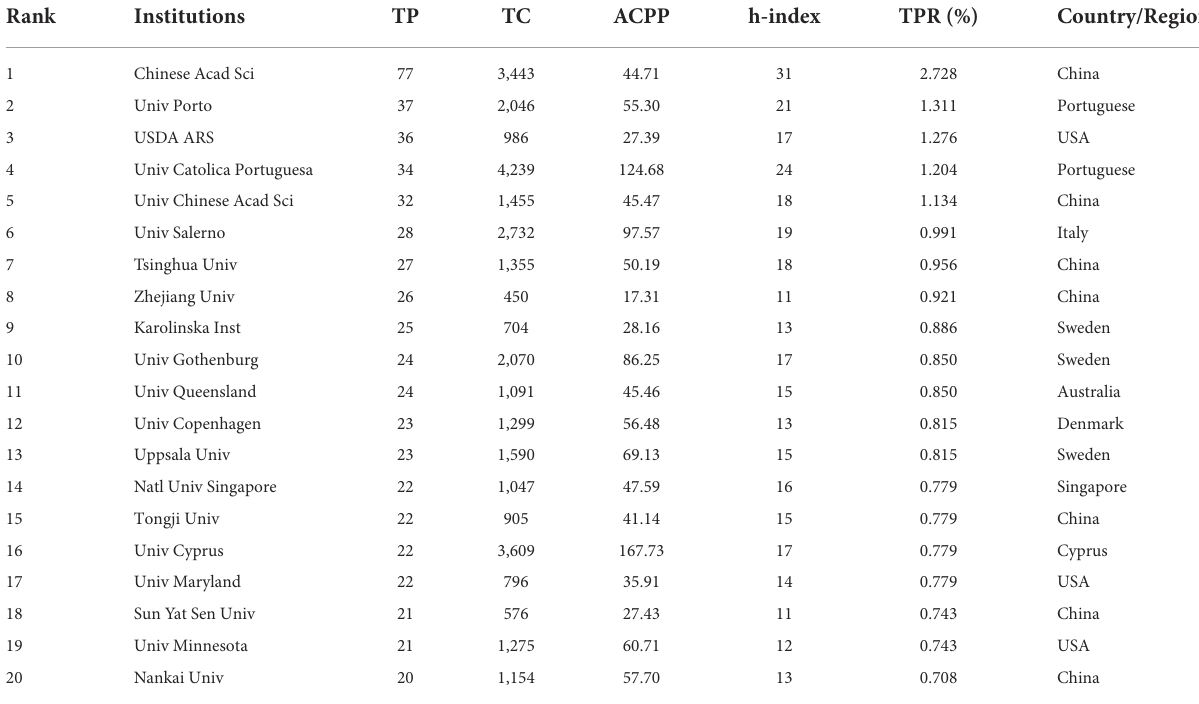
TABLE 2 The top 20 most productive institutions in the ARB field during